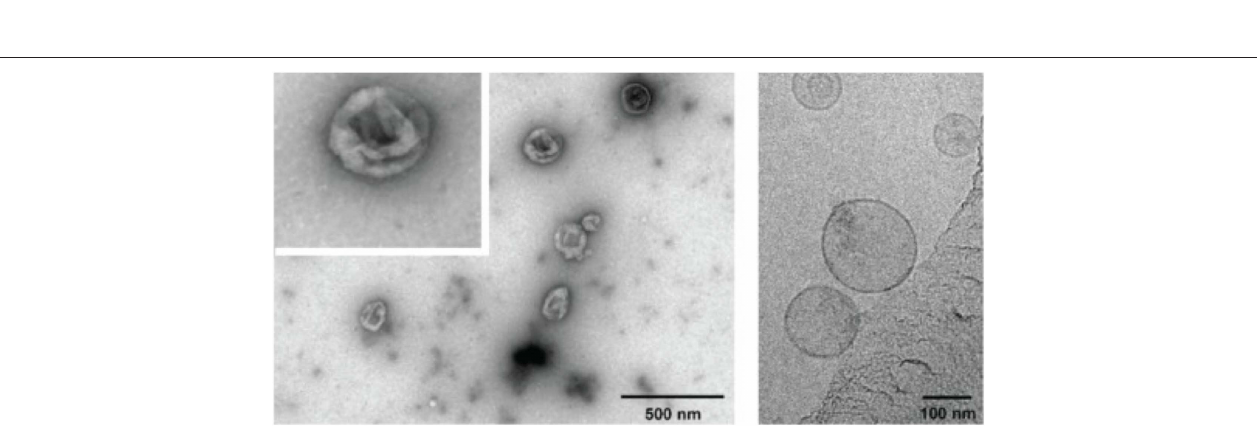
FIGURE 2 | Electron micrographs of exosomes. Exosomes were isolated from cultured primary endothelial cells. Left: exosomes were stained with uranyl acetate and embedded as whole mount preparations in methylcellulose. The image shows a cup-shaped morphology and heterogeneous sizes ranging from 30 to 100nm. Right: Exosomes were analyzed by cryoelectron microscopy without chemical fixation or contrasting. Exosomes appear as round membranous structures. Adapted from panels B and C in Figure 1 of Banizs et al., © 2014, originally published in International Journal of Nanomedicine (Dovepress). https://doi.org/10.2147/IJN.S64267.